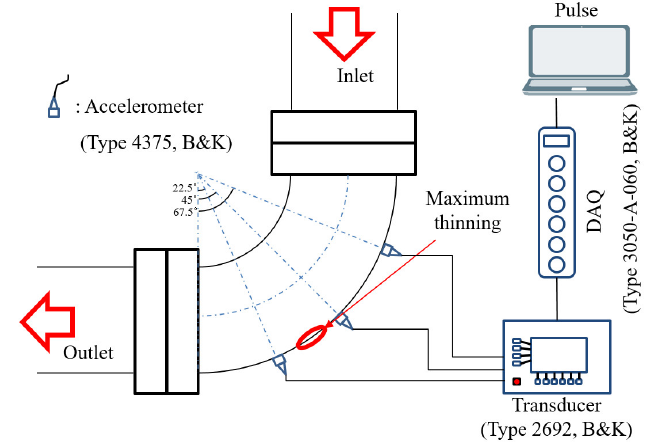
Figure 2. Vibration signal measurement system and accelerometer positions at the surface of the curved pipe.